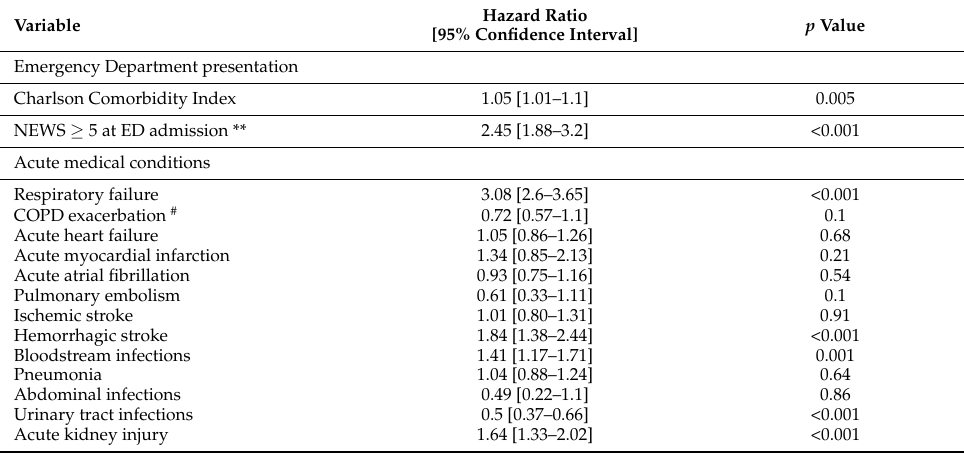
Table 5. Hazard ratio for in-hospital mortality in patients with